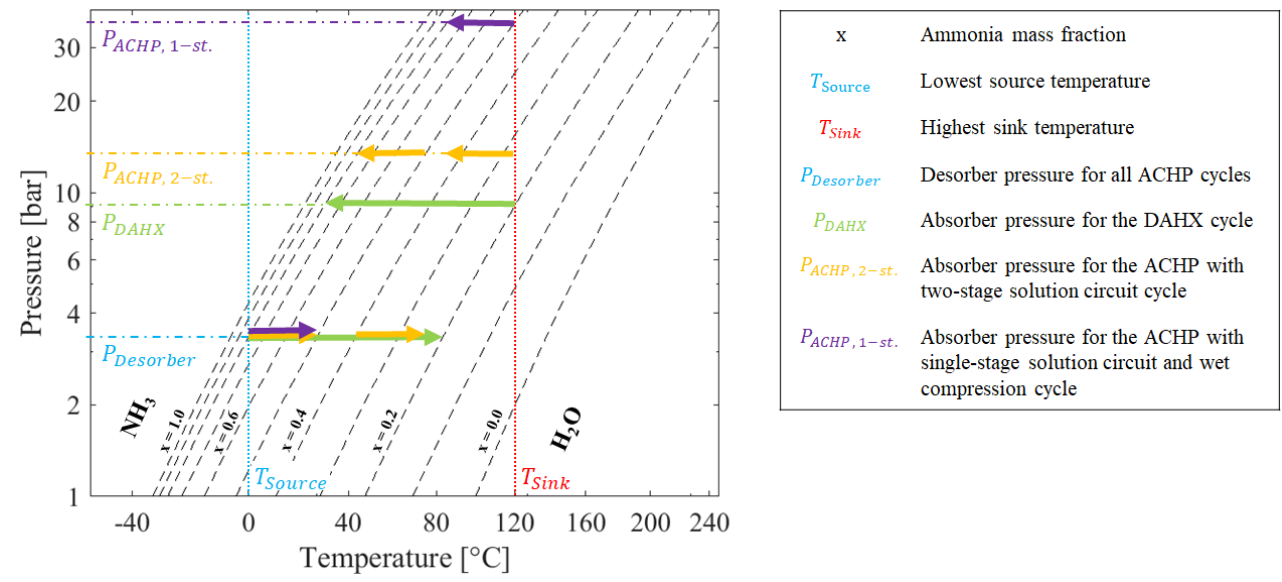
Figure 3. Simplified comparison of the described ACHP cycles in a ln p–1/T diagram (adapted from Groll (1997) [18]).